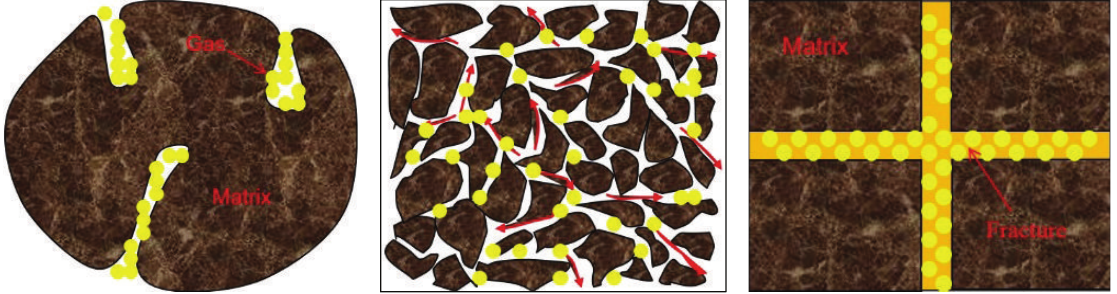
Figure 2: Desorption and diffusion in the CBM reservoirs.